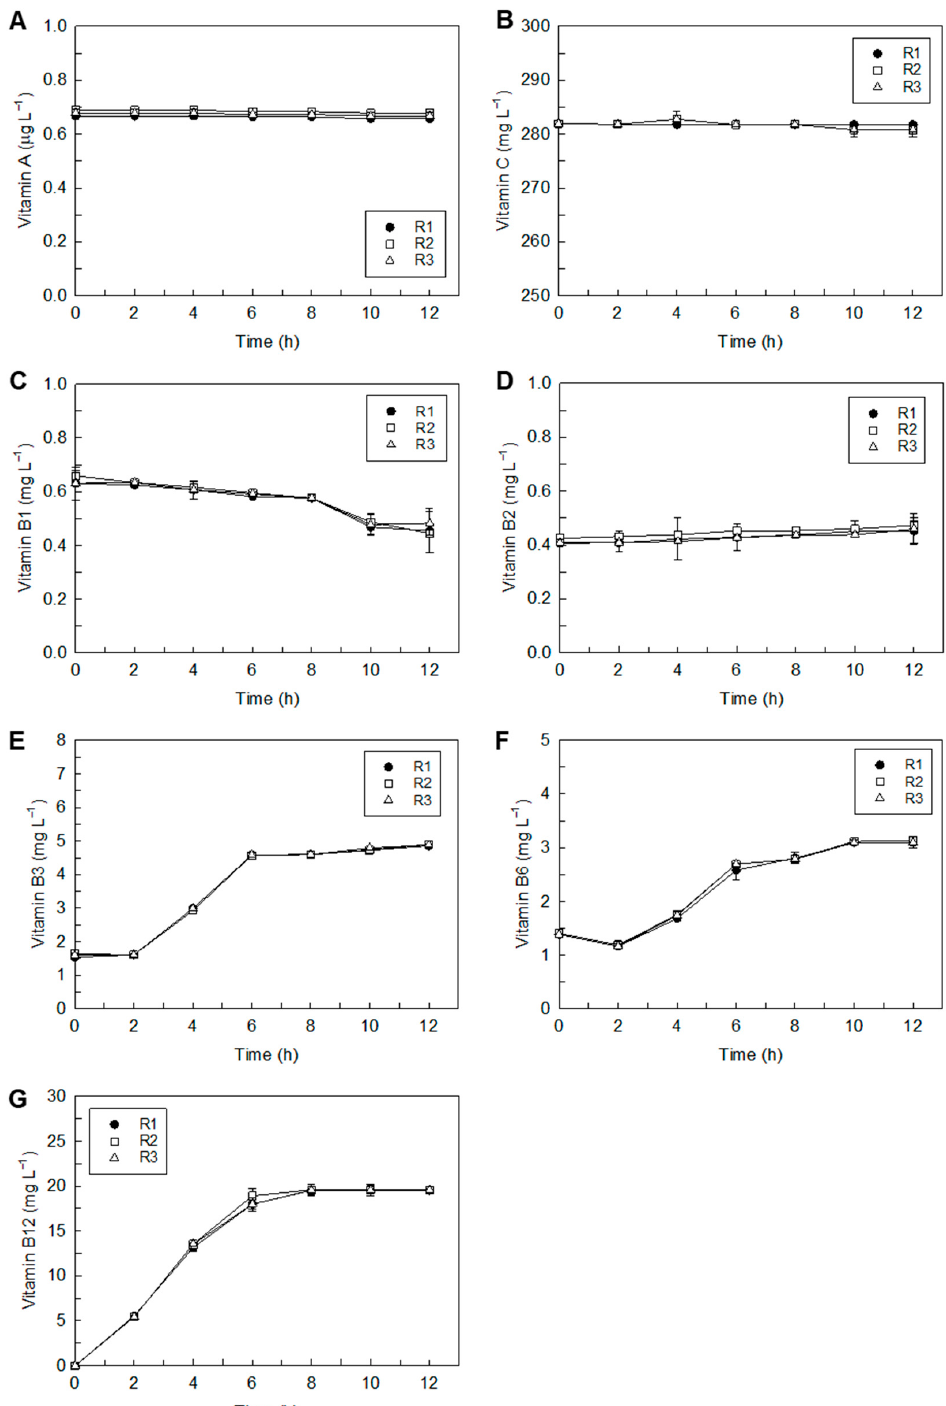
Figure 2. Vitamin concentrations in whole pineapple juice during culture of L. plantarum WU-P19: ( A ) vitamin A (retinal); ( B ) vitamin C (ascorbic acid); ( C ) vitamin B1 (thiamin); ( D ) vitamin B2 (riboflavin); ( E ) vitamin B3 (niacin); ( F ) vitamin B6 (pyridoxine); ( G ) vitamin B12 (cyanocobalamin). (R1, fermented whole pineapple juice without malt extract; R2, fermented whole pineapple juice with 2% w / v of malt extract; R3, fermented whole pineapple juice with 5% w / v of malt extract). Data are averages ± standard deviations of nine measurements (three replicate samples × three replicate fermentations) of fermented whole pineapple juice (R1, R2, and R3).